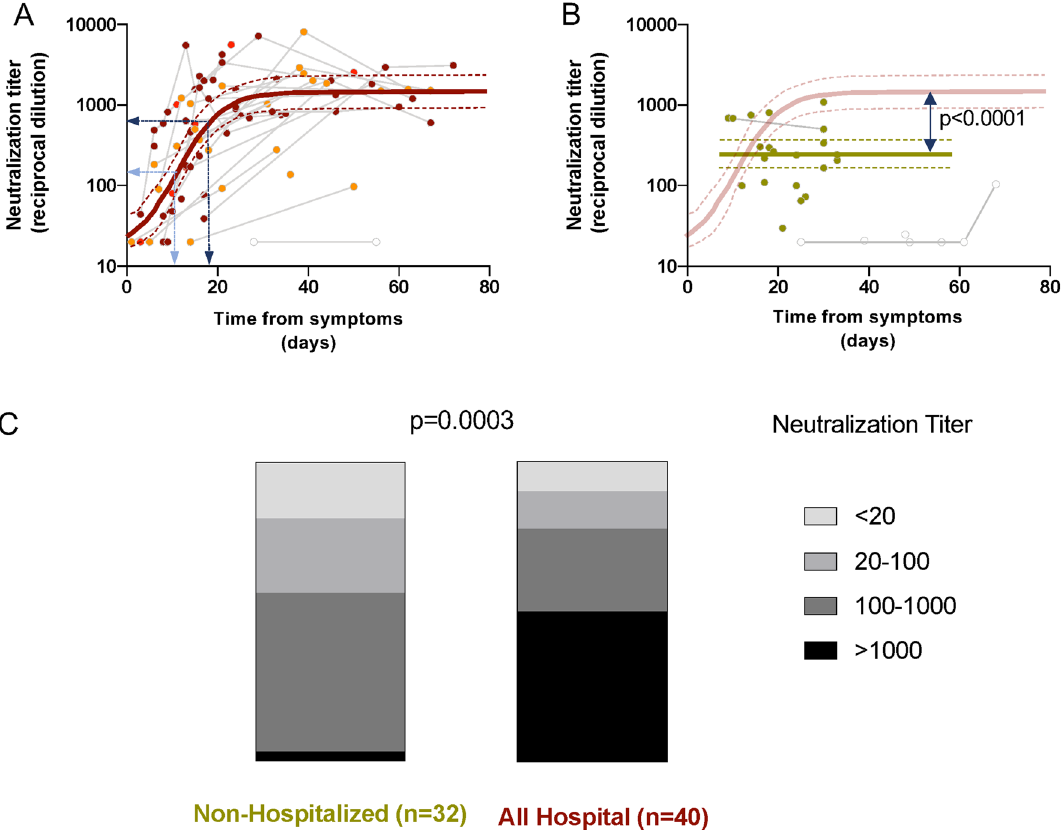
Figure 2. Longitudinal analysis and distribution of neutralization activity. ( A ) Neutralization titers from hospitalized patients were plotted against time from symptoms onset and fitted (solid line). Empty symbols indicate outliers. Light and dark blue arrows indicate the calculated time required to achieve the 50% and the 80% maximal neutralization titer, respectively. Non severe, severe and ICU groups are indicated by orange, maroon and red symbols, respectively. Analysis was performed with all the dataset. ( B ) Neutralization titers from mild-symptomatic individuals were fitted (solid line) after identification of outliers (empty symbols). The comparison of the plateau values for neutralization titers in hospitalized (light maroon line) and mild- symptomatic individuals is shown (Z test). ( C ) Representation of the frequency of undetectable, low, medium and high neutralizing individuals in non-hospitalized and hospitalized (All hospital) patients (p-value of Chi- square